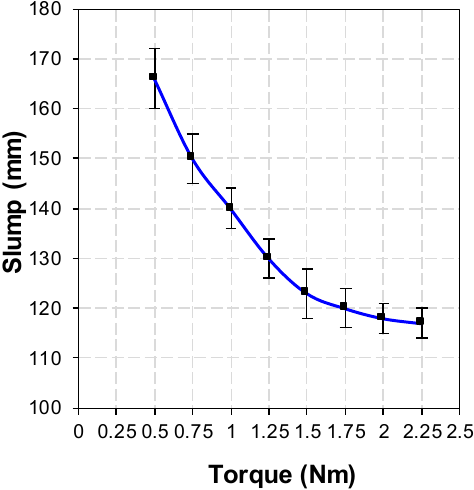
Figure 3. Relationship between torque and slump for the 3D concrete printing system.